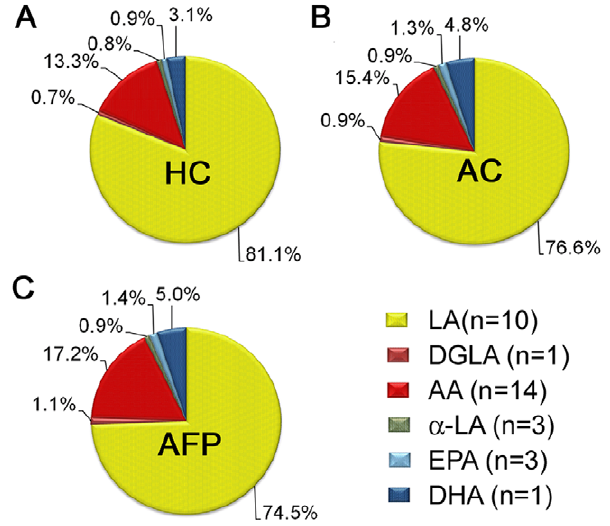
Figure 2. Oxylipin composition based on polyunsaturated fatty acid class. ( A ) Healthy controls (HC) ( B ) Asthmatic controls (AC) and ( C ) Asthmatics following provocation (AFP). Oxylipins were grouped into the following classes based upon their fatty acid substrate: